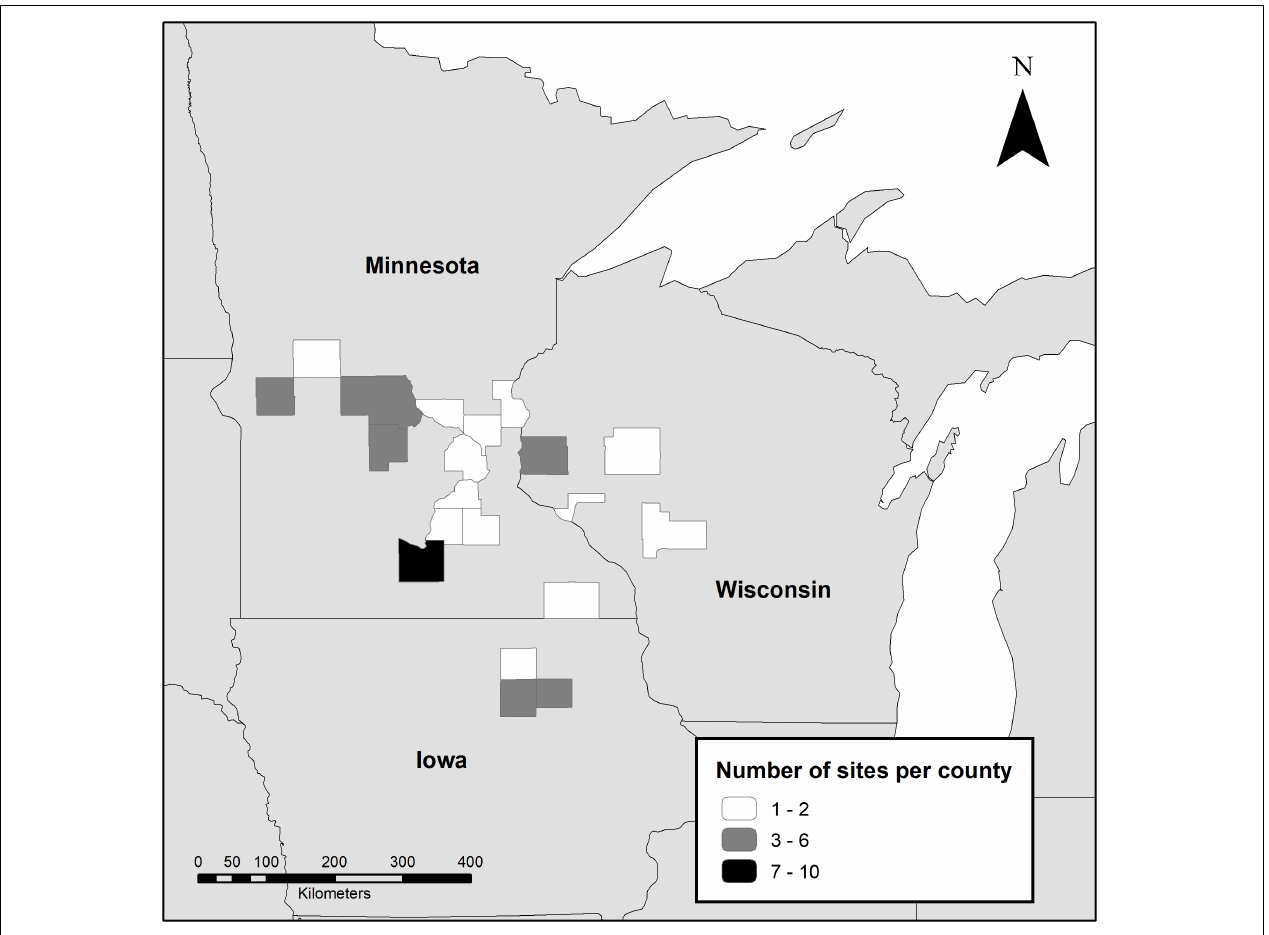
FIGURE 1 | Location of study sites surveyed for monarchs, milkweed, and blooming plants during 2016 and 2017 by county.